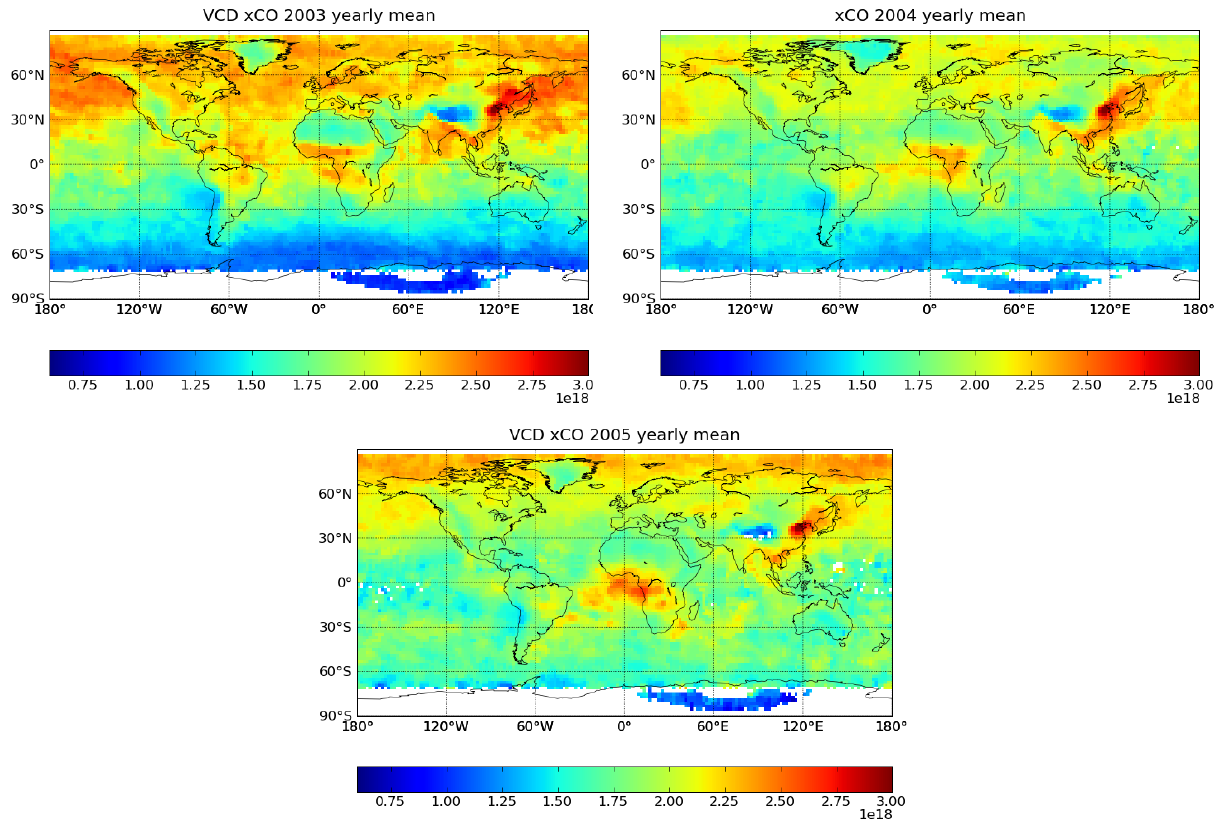
Fig. 17. Annual mean carbon monoxide vertical column densities [moleccm − 2 ] for 2003 to 2005. (1 ◦ × 1 ◦ grid with 3 ◦ × 3 ◦ median filter